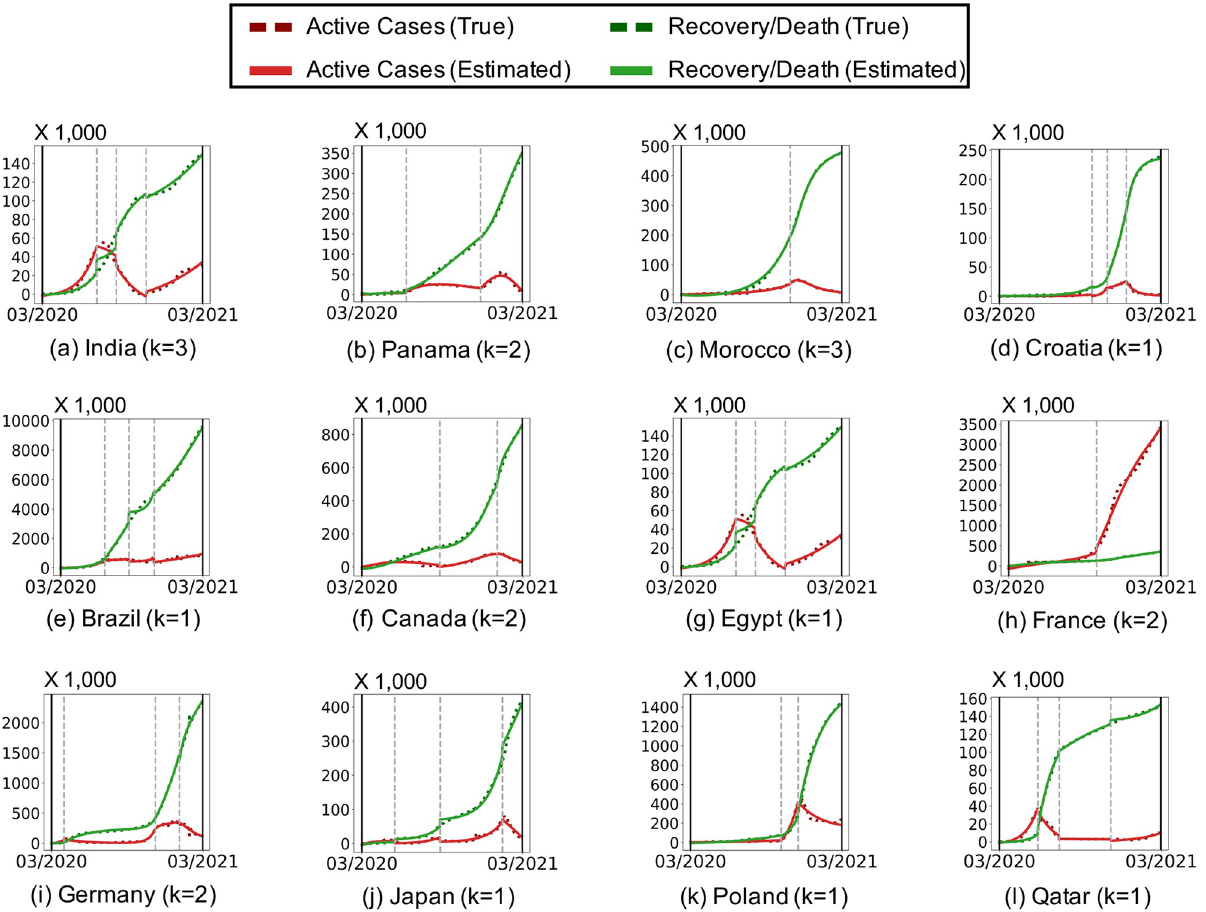
Fig 3. Simple models with multiple segments are preferred over complex models without segments. The true and estimated event sequences when the description length in bits is minimized.